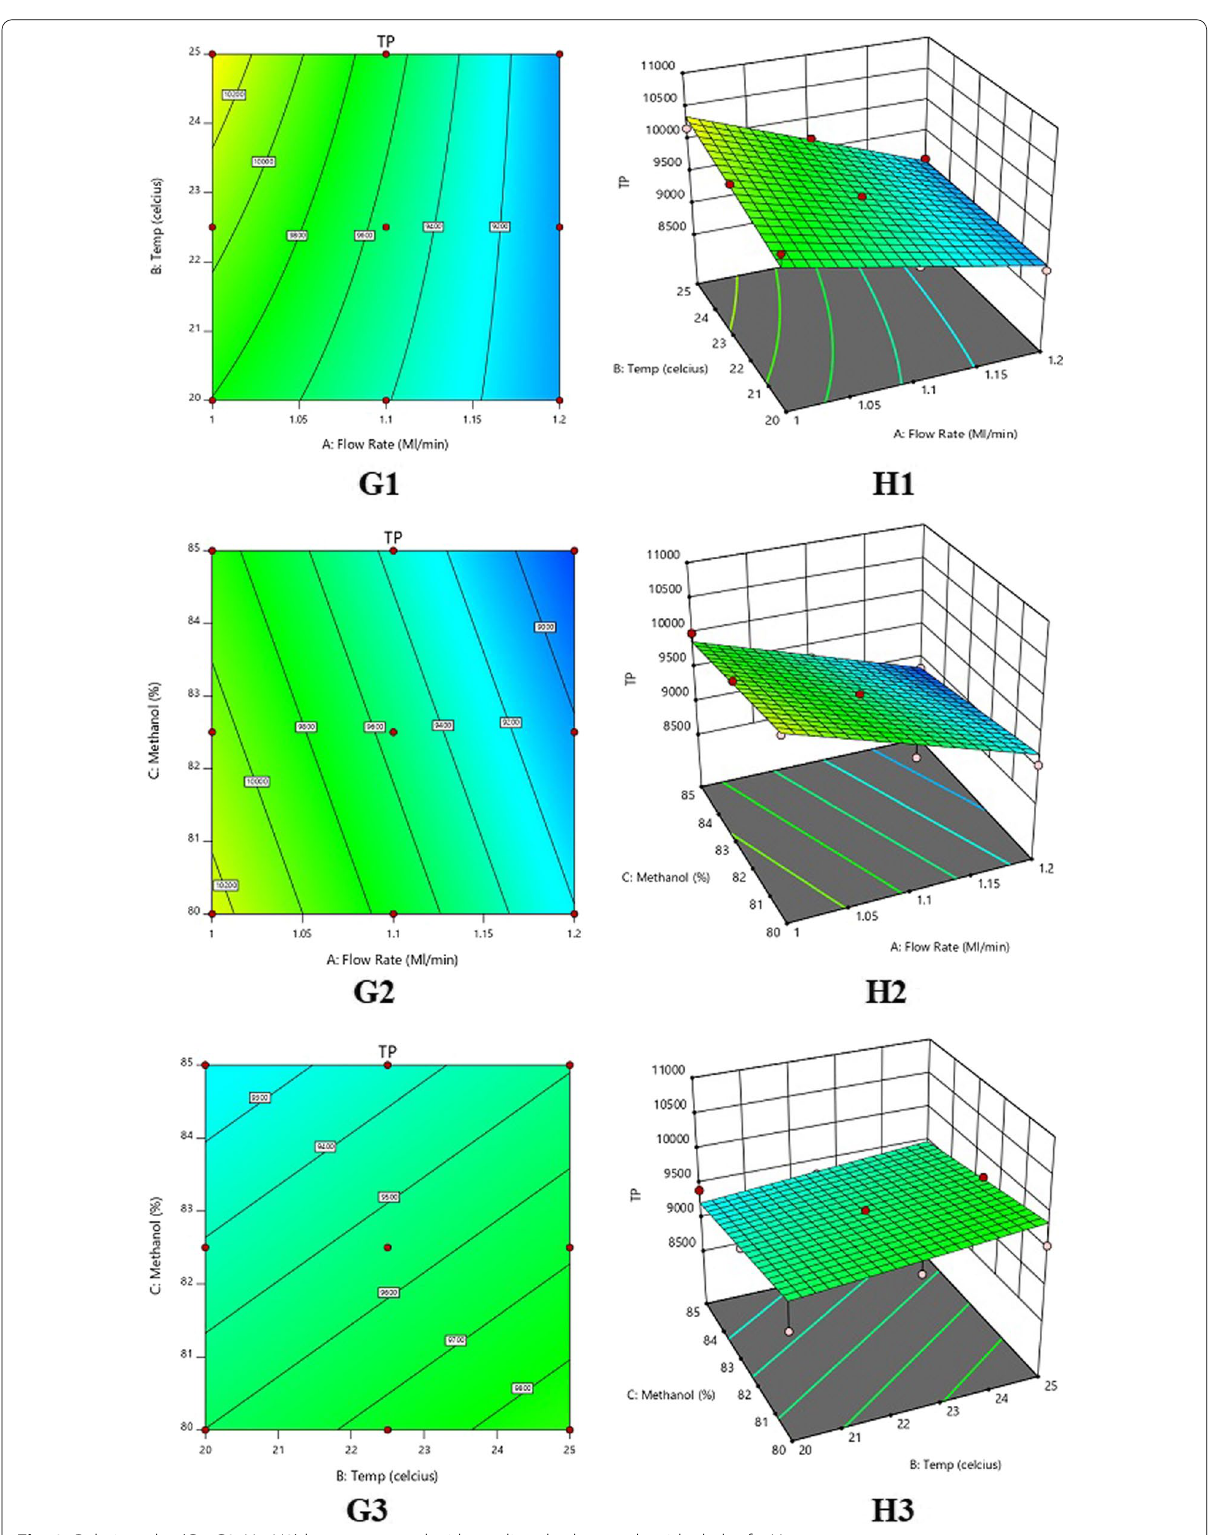
Fig. 9 Relation plot (G1-G3; H1-H3) between actual with predicted values and residual plot for